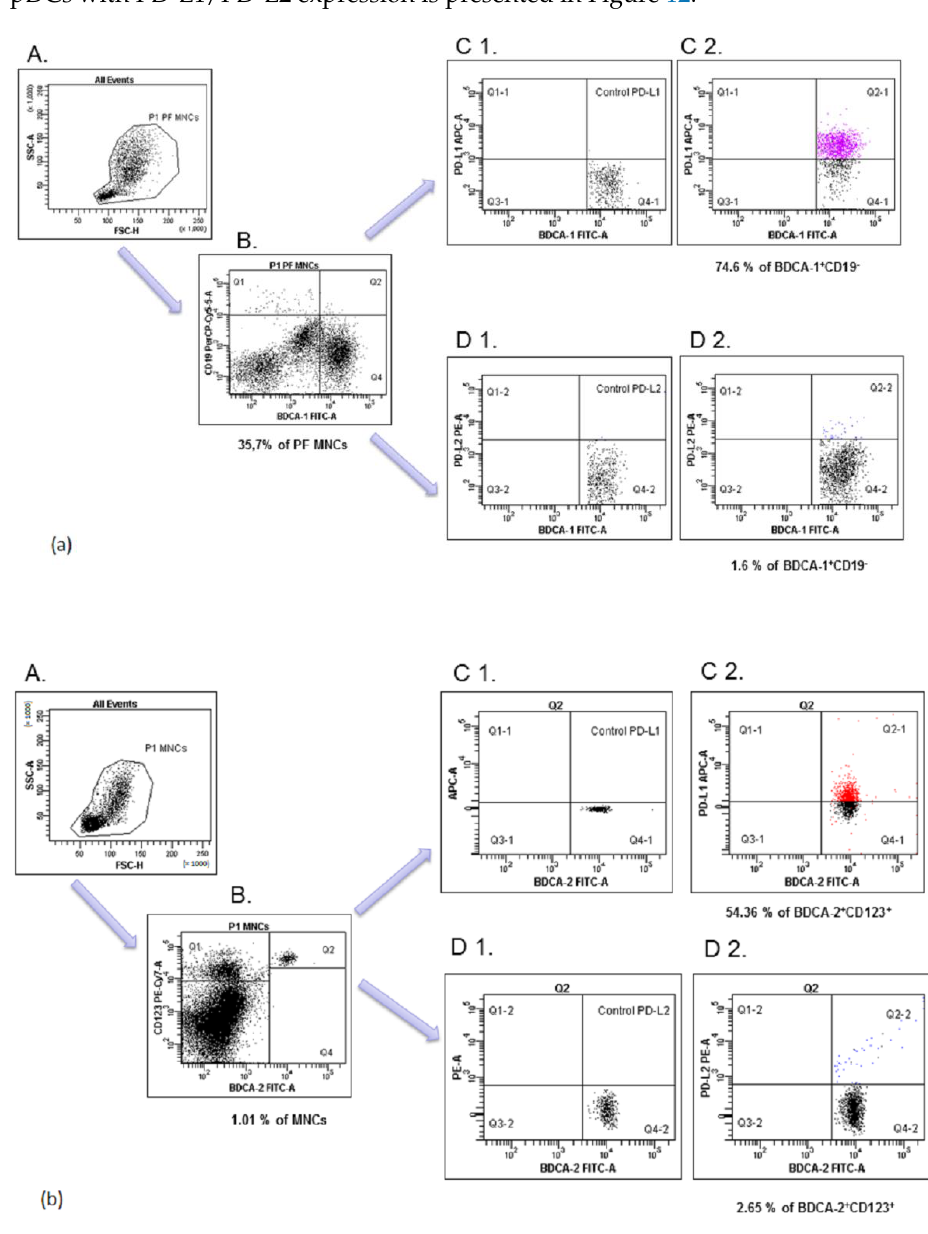
Figure 12. Flow cytometric analysis of BDCA-1 + CD19 − and BDCA-2 + CD123 + dendritic cells with PD-L1 and PD-L2 expression in the PF ( a ) and PB ( b ) of the patient with EMS. An acquisition gate was established based on FSC and SSC that included mononuclear cells (P1 population;